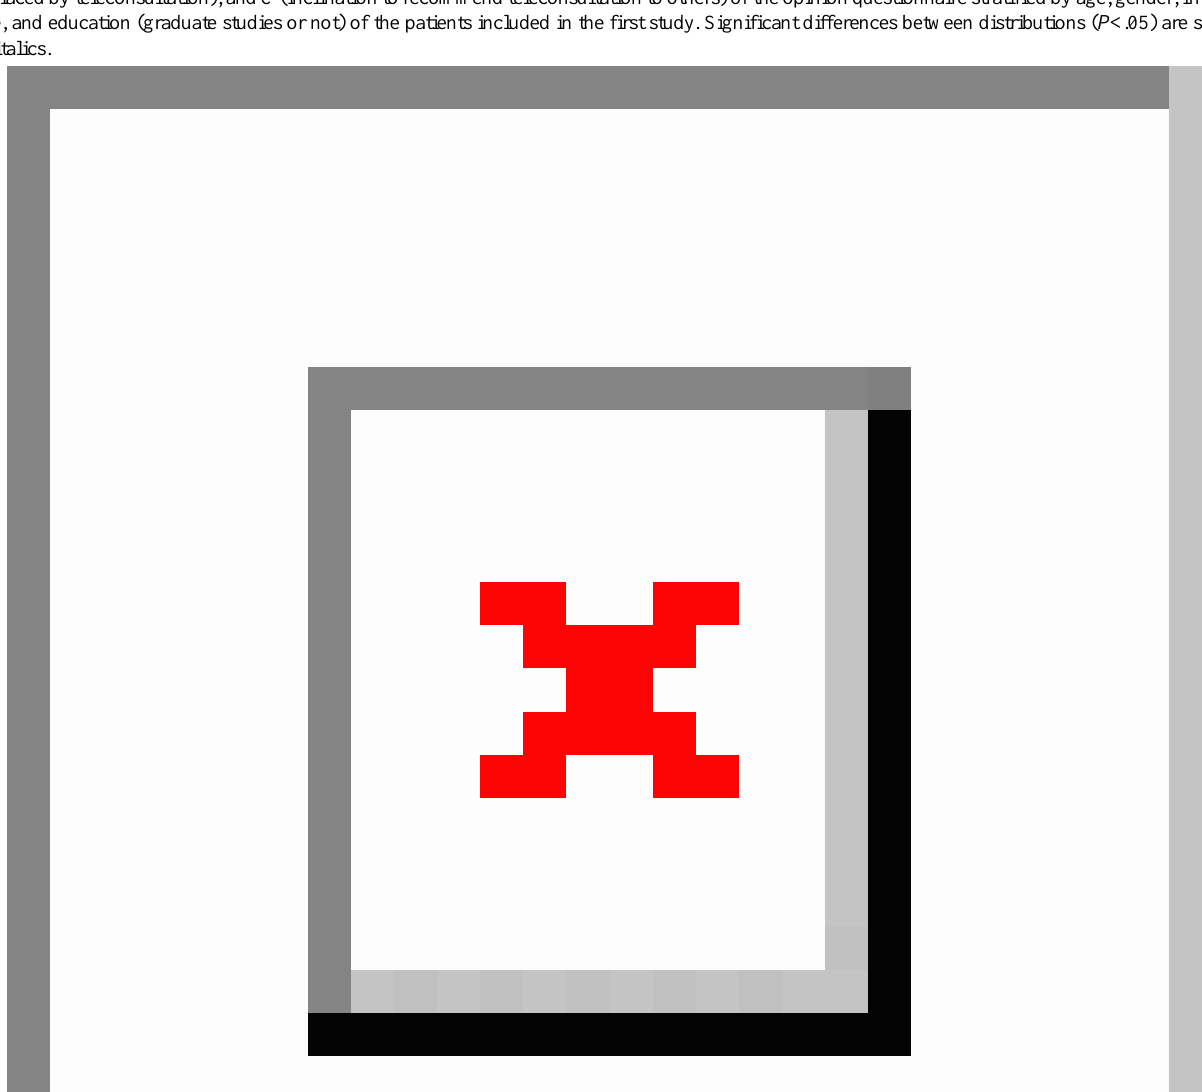
Figure 1. Frequency distribution of the answers to question A (satisfaction with the teleconsultation), B (percentage of face-to-face that could be replaced by teleconsultation), and C (inclination to recommend teleconsultation to others) of the opinion questionnaire stratified by age, gender, Internet use, and education (graduate studies or not) of the patients included in the first study. Significant differences between distributions ( P <.05) are shown in